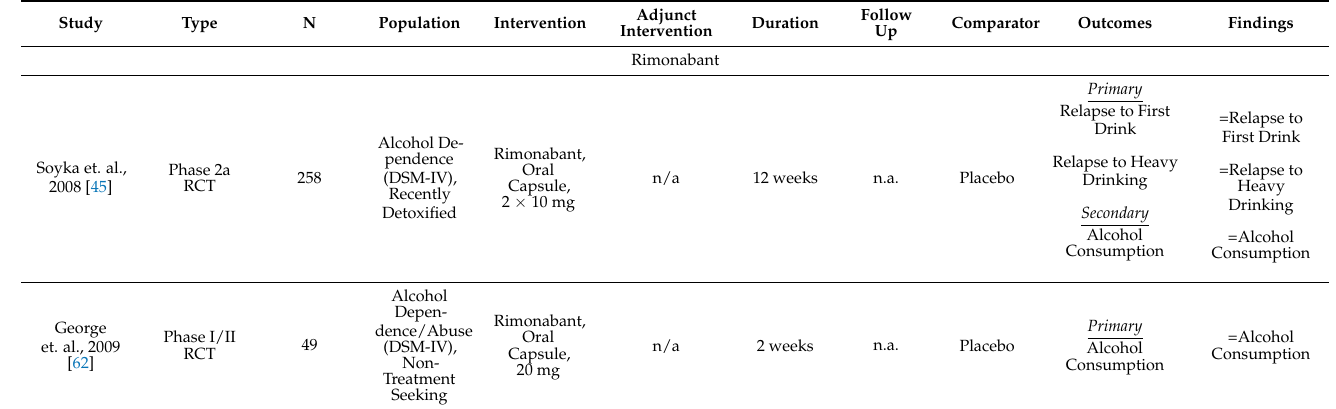
Table 5. Primary Studies pertaining to Alcohol Use Disorder.